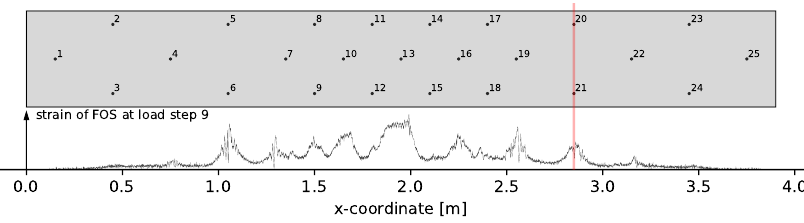
Figure 6. Comparison of FOS data to transducer positions at load step 9.